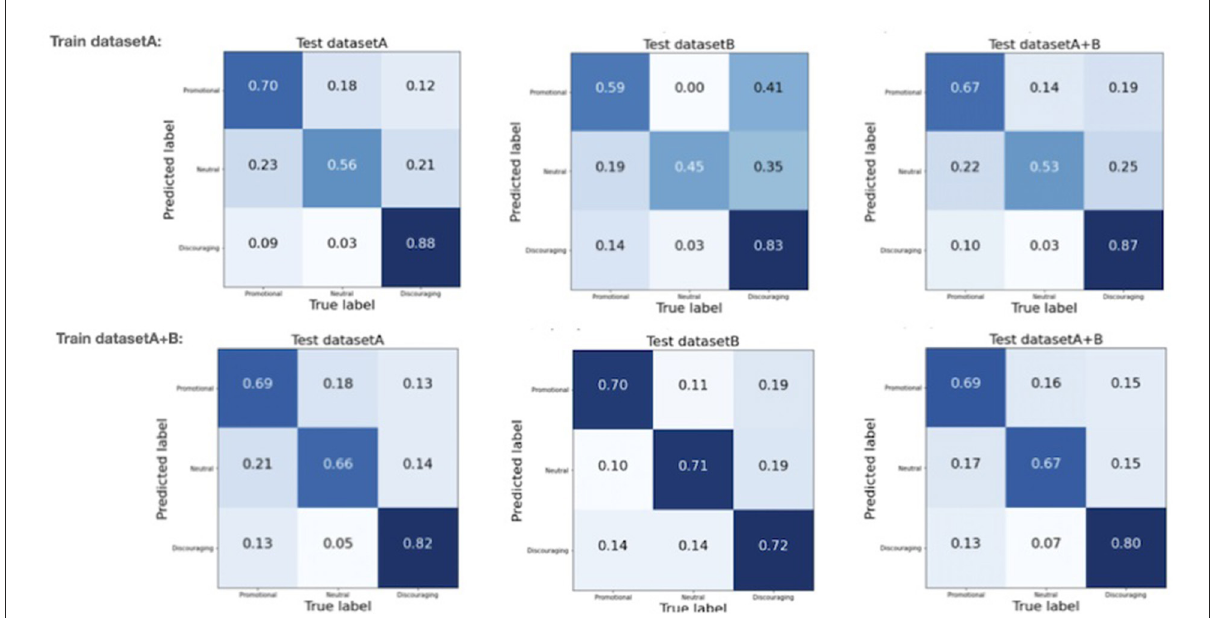
FIGURE2 Normalized confusion matrices for the final selected fine-tuned model. Top row: XLM-Roberta-large model trained on dataset A. Bottom row: XLM-Roberta-large model trained on the combined datasets (dataset A + B). On the left, the matrices when the model is tested on dataset A. In the centre, the matrices when the model is tested on dataset B. On the right, the matrices when the model is tested on the combined datasets.